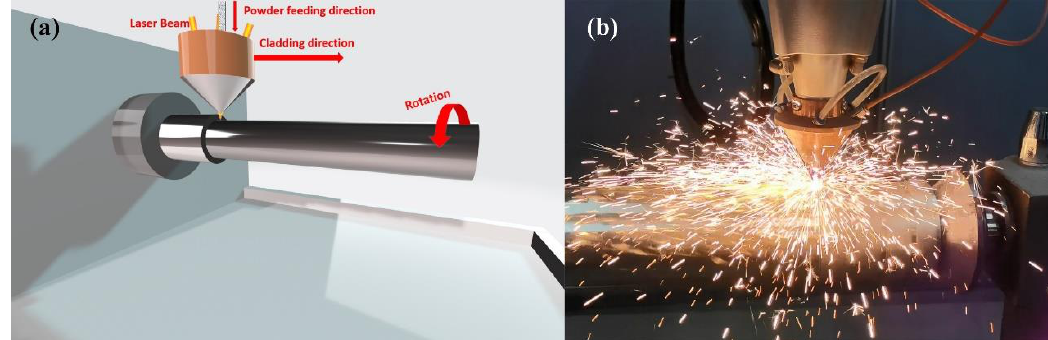
Figure 2. Diagram of laser cladding: ( a ) experimental platform; ( b ) the actual process. Table 2. Processing parameters for Inconel625 alloys coatings prepared by UHSLC and LSLC. Laser Power Cladding Rate Powder Feeding Speed Form Overlap Rate (W) (m/min) (g/min) UHSLC 2200 30 32.3 85% LSLC 2200 2 32.3 85%